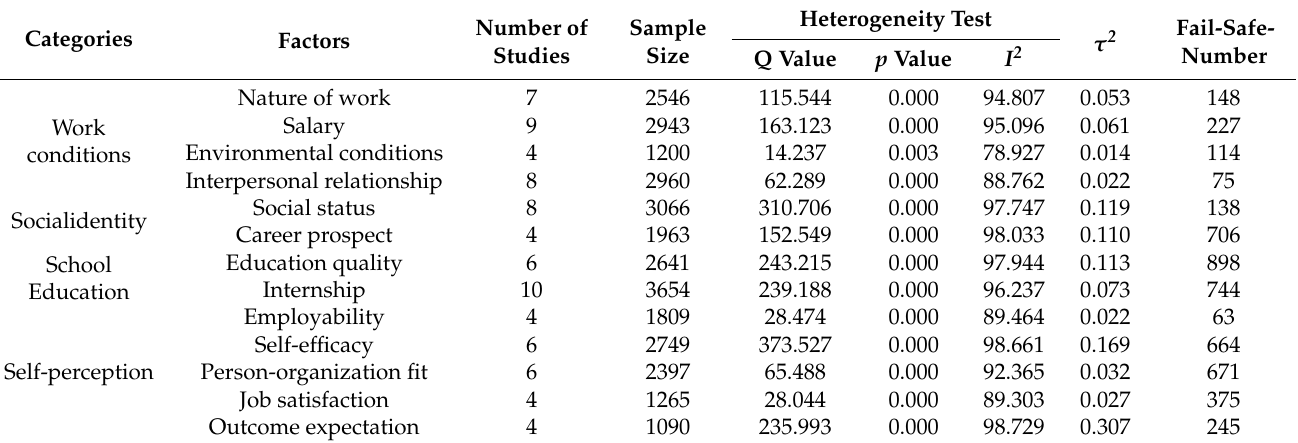
Table 2. Publication bias analysis and heterogeneity test